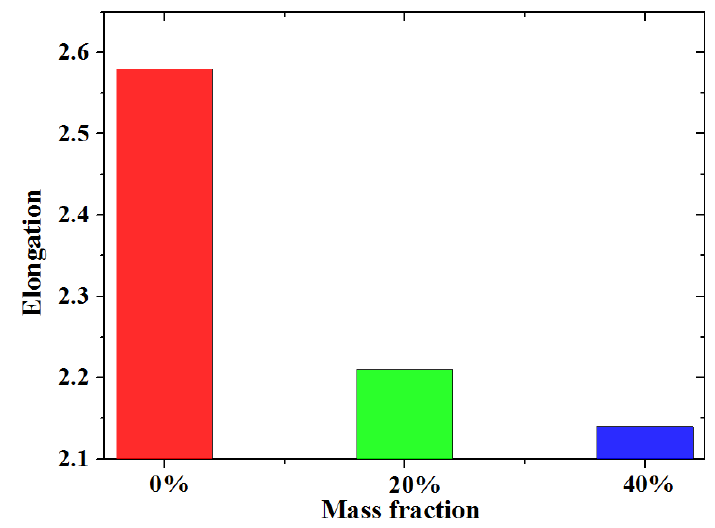
Figure 14. Elongation of the silicone with different mass fractions by experimental results (aging time 0 h, strain rate 1.8 × 10 − 3 /s).